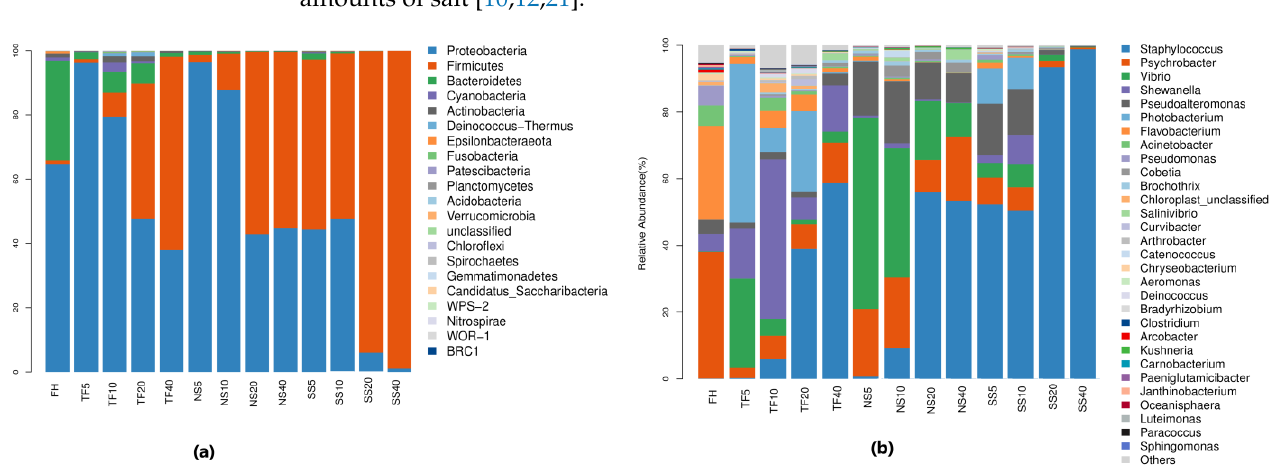
Figure 1. Bacterial community structures. ( a ) Relative abundance of the bacteria of fresh and salted herrings at the phylum level (Top 20 was selected); ( b ) relative abundance of the bacteria of fresh and salted herrings at the genus level (Top 30 was selected).